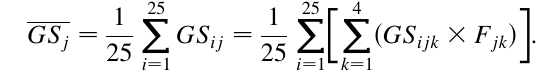
The PCK score of each graduate student and random guesser ( GS i , RG i as described above) were used to obtain averages and standard deviations in order to perform t -tests to compare the performance of graduate students with random guessing on the whole survey (and to compare different subgroups of graduate students). In order to compare the performance of these different groups on individual items, the averages and standard deviations of the PCK scores on that particular item (e.g., perform t